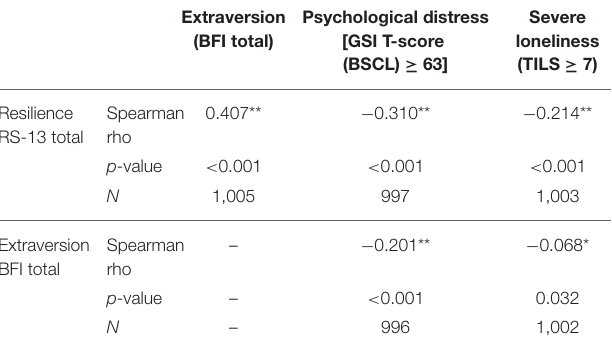
TABLE 3 | Association of resilience and extraversion with psychological distress and severe loneliness (Spearman rank correlation